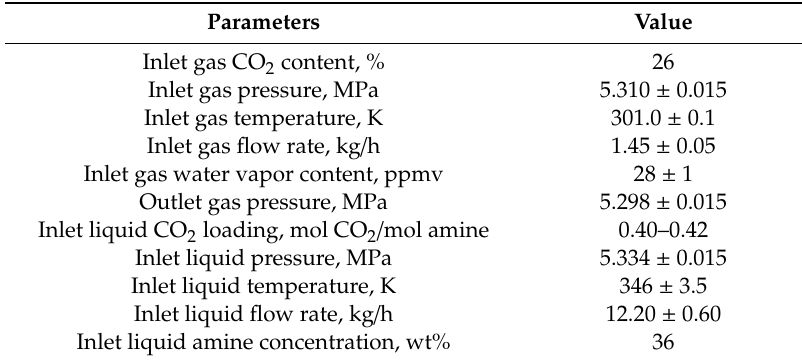
Table 2. Initial experimental conditions.